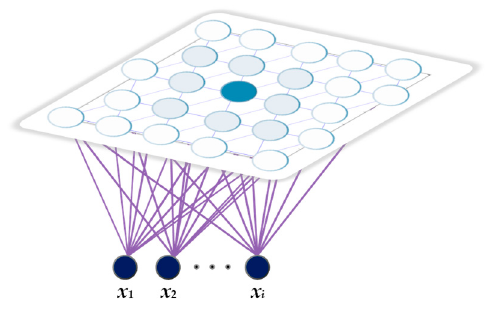
Figure 4. General architecture of Kohonen map.